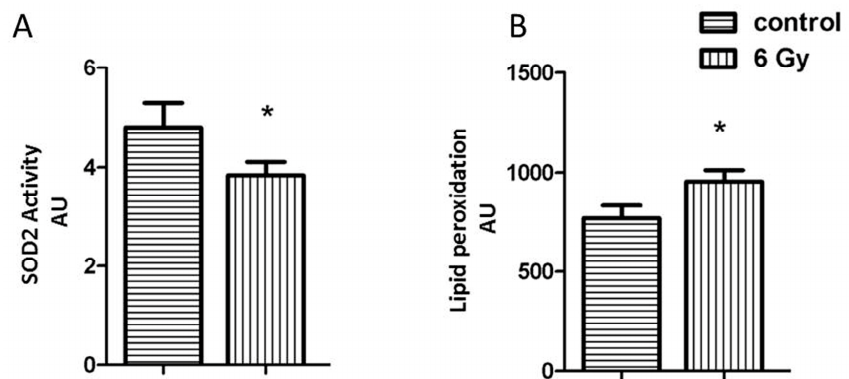
Figure 4. Analysis of the mitochondrial oxidative stress response. The expression level of mitochondrial SOD2 ( A ) and the amount of lipid peroxidation ( B ) as a marker of oxidative stress was measured in irradiated and control samples. The error bars represent standard error of the mean ( ± SEM) (t-test; * p < 0.05; n = 4).